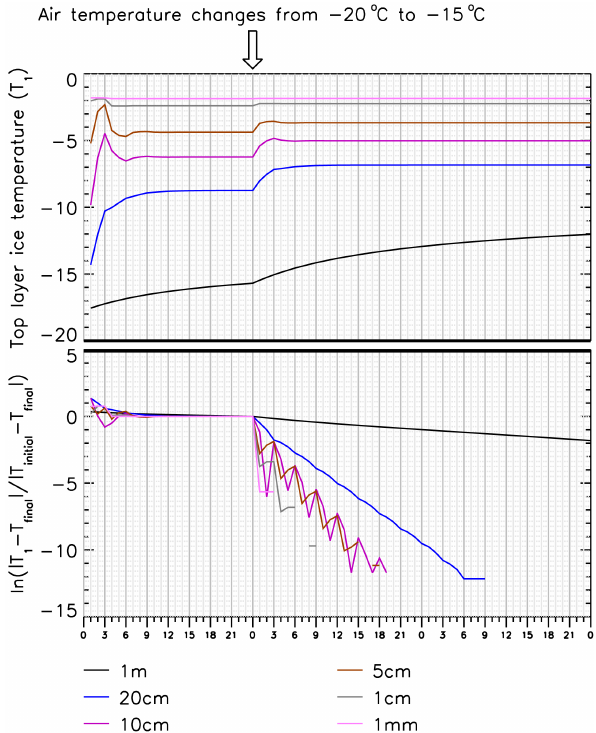
Figure A1. Showing the evolution of top layer ice tempera- ture following a sudden change in air temperature, under the JULES coupling method. The lower panel shows the evolution of (cid:17) (cid:16) | T 1 − T final | to allow easy comparison of the rates of conver- ln | T initial − T final | gence for differing ice thicknesses, where T 1 , T final , and T initial re- spectively refer to the evolving top layer ice temperature, the value of top layer ice temperature after 3 days, and the value at 1 day, at the time of the perturbation. The graph disappears when the differ- ence falls below minimum